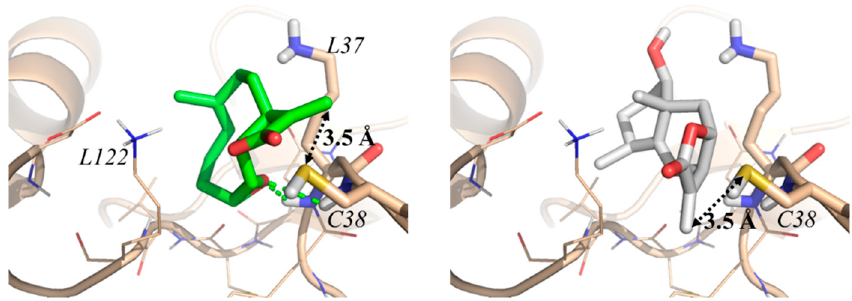
Figure 5. The docking mode of parthenolide ( P , left, green) and 1 (right, gray) through binding to NF- κ B/p65 (PDB: 1VKX). 1 can superimposed well with P in the p65 binding site and the spatial distance between both the α -methylene and SH group of C38 is about 3.5 Å.